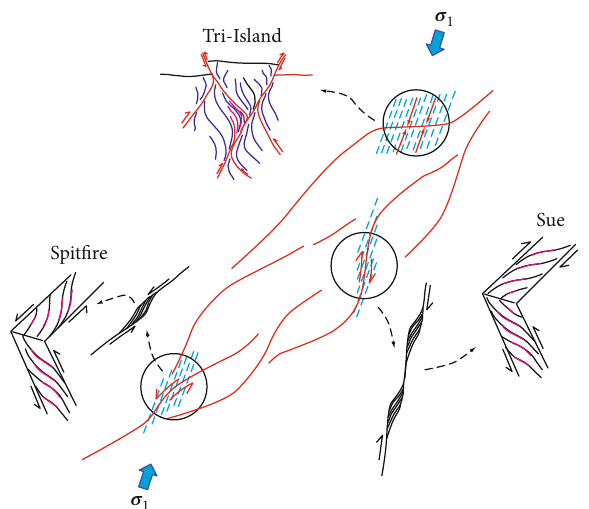
Figure 21: Sketch representing the reactivation of shear zones and the formation of dilational jogs and conjugated faults depending on their orientation respect to a NNE σ 1: reverse left-lateral in Spit fi re, reverse right-lateral in Sue, and conjugated in Tri-Island. Mineralization is in